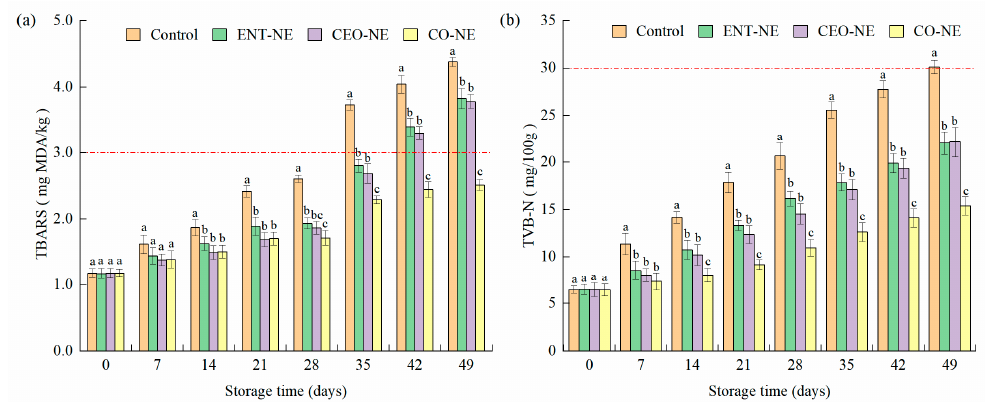
Figure 5. Changes in TBARS ( a ) and TVB-N ( b ) values of liquid-smoked salmon fillets treated with nanoemulsions containing enterocin Gr17 alone (ENT-NE), cinnamaldehyde alone (CEO-NE), enterocin Gr17 and cinnamaldehyde (CO-NE) and no enterocin Gr17/cinnamaldehyde (Control) during storage at 4 ◦ C for 49 days. The red dotted line means the minimal acceptable limit. Bars with no letter in common for each treatment are significantly different ( p < 0.05) .